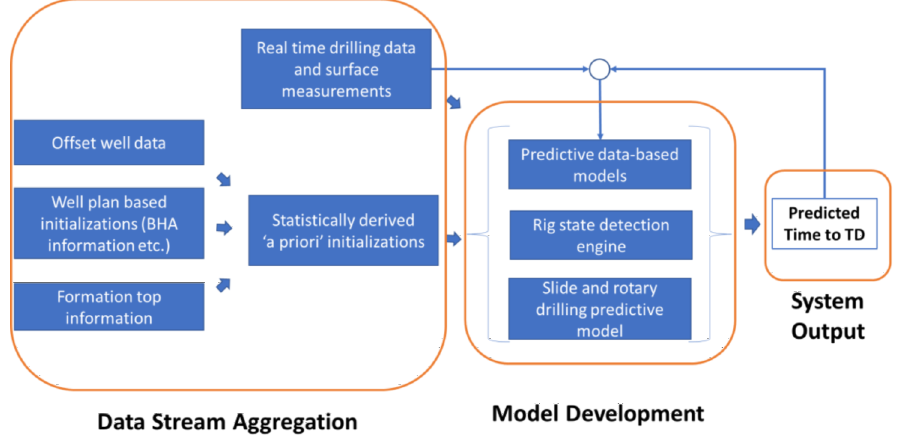
Figure 9. Final structure of the designed digital twin for making time to TD predictions, see also